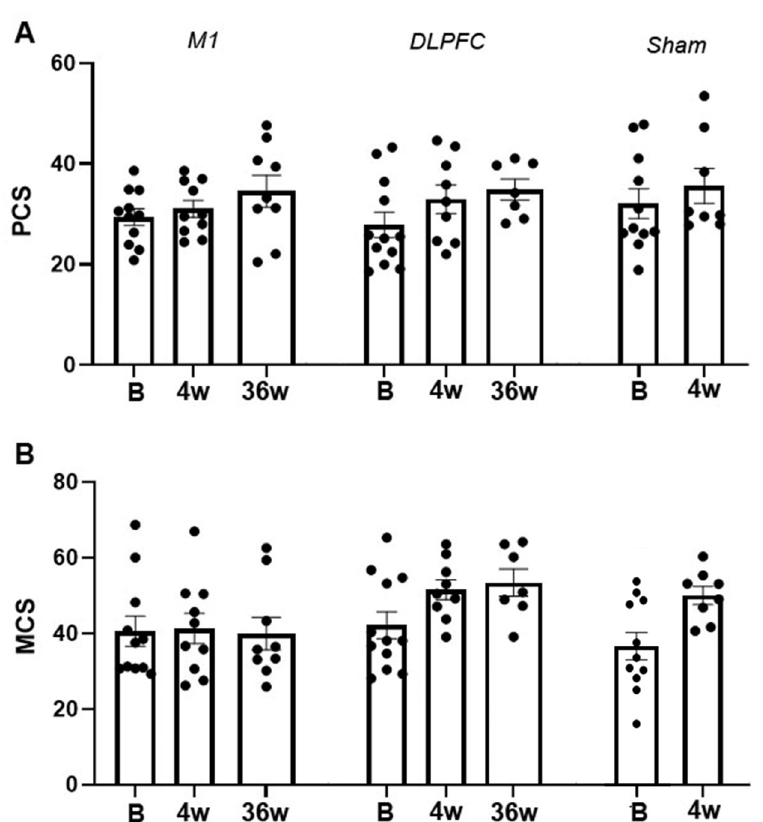
Figure 7. rTMS effects on SF-12 physical composite summary ( A ) and mental composite summary ( B ). The y-axis indicates the mean score, and the x-axis indicates the time points (in weeks) of conducted measurements. Each dot indicates the individual patients’ summary. PCS = physical composite summary; MCS = mental composite summary; B = baseline; w = week; M1 = primary motor cortex; DLPFC = dorsolateral prefrontal cortex; Error bars denote mean ± SEM.